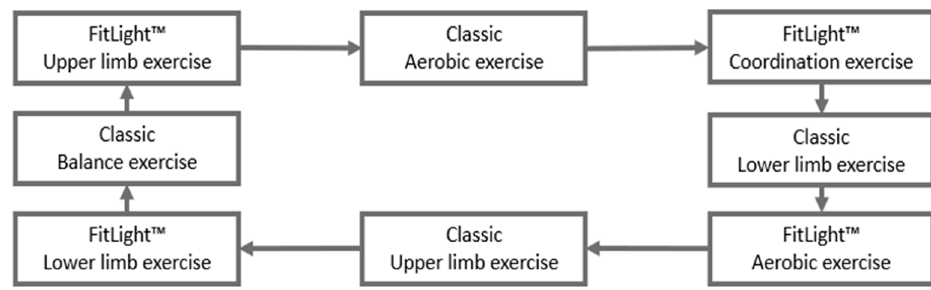
Figure 3. Example of the organization of the CT-fit stations.